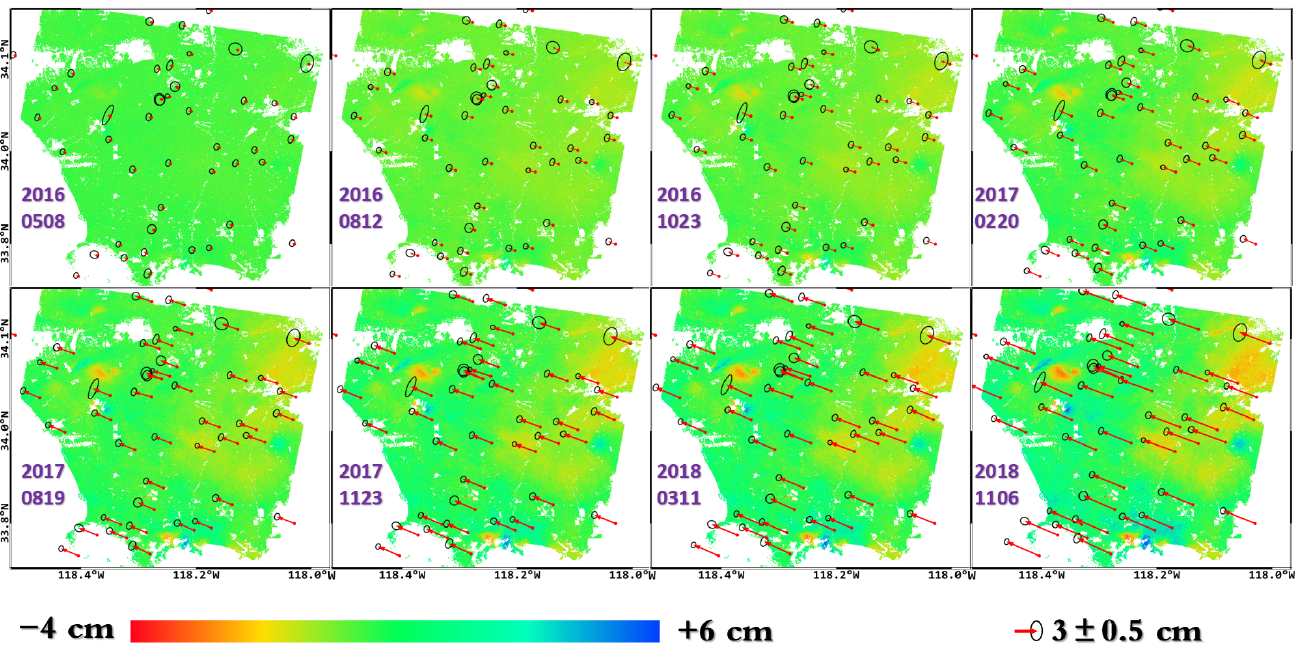
Figure 7. Deformation time series maps of descending InSAR. GNSS sites with displacement vectors are indicated by red arrows. The black ellipses represent the horizontal